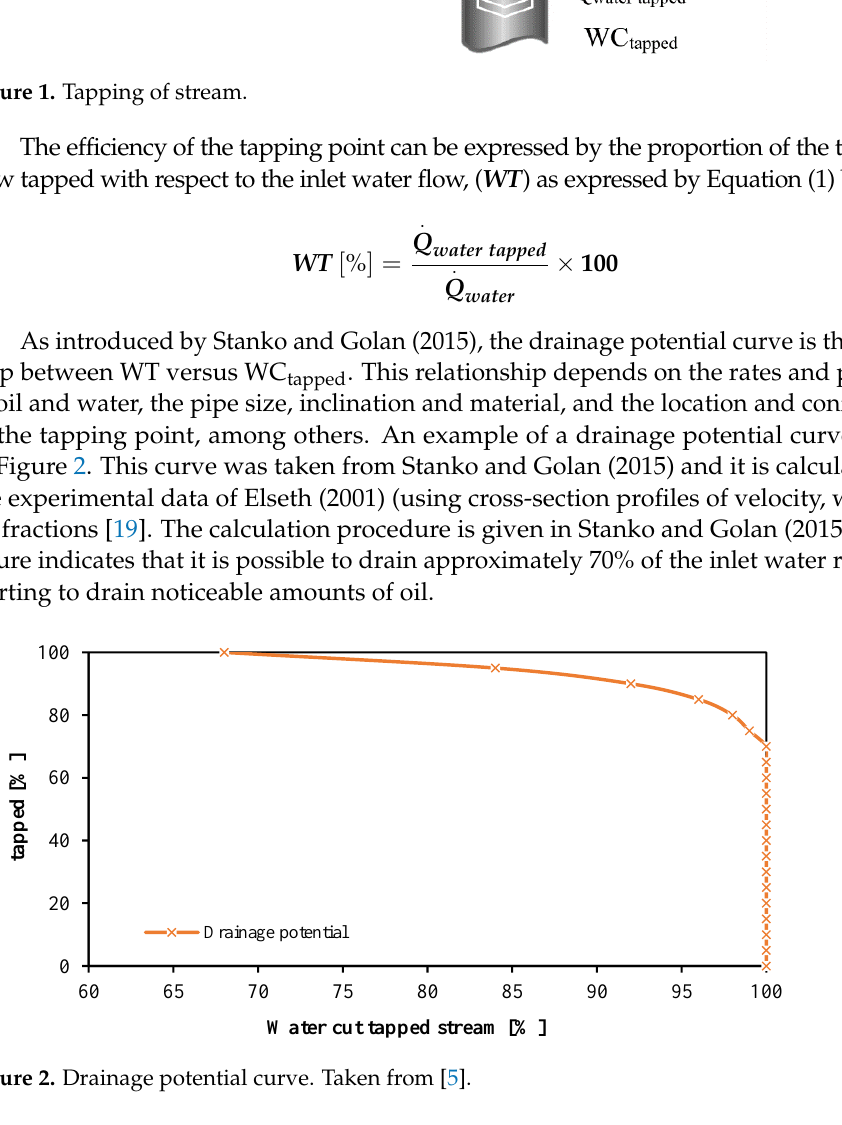
Figure 2. Drainage potential curve. Taken from [5].